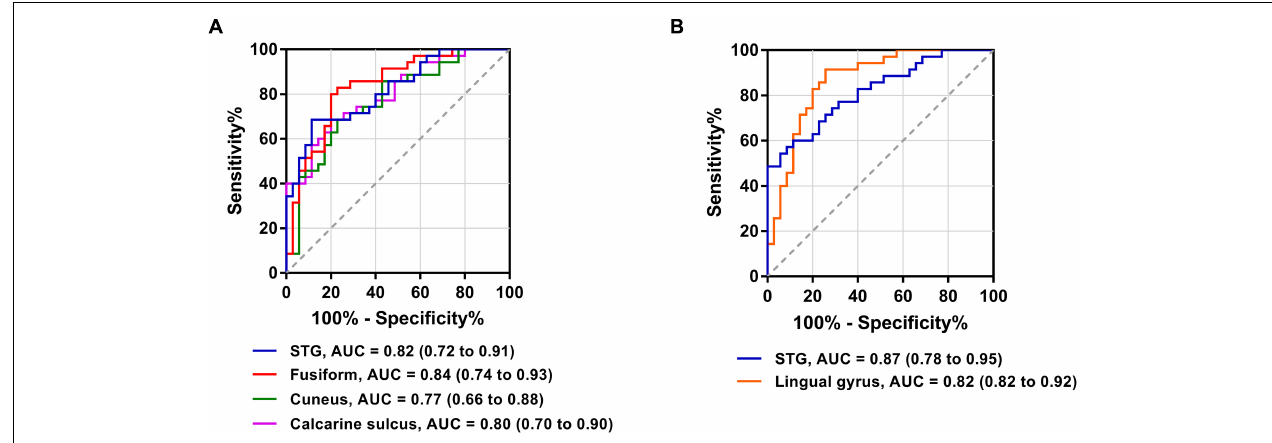
FIGURE 3 | Receiver operating characteristic curves for differentiating patients with SNHL and healthy controls based on the significant FC with the left dlPFC (A) and right dlPFC (B) . AUC, area under the receiver operating characteristic curve.